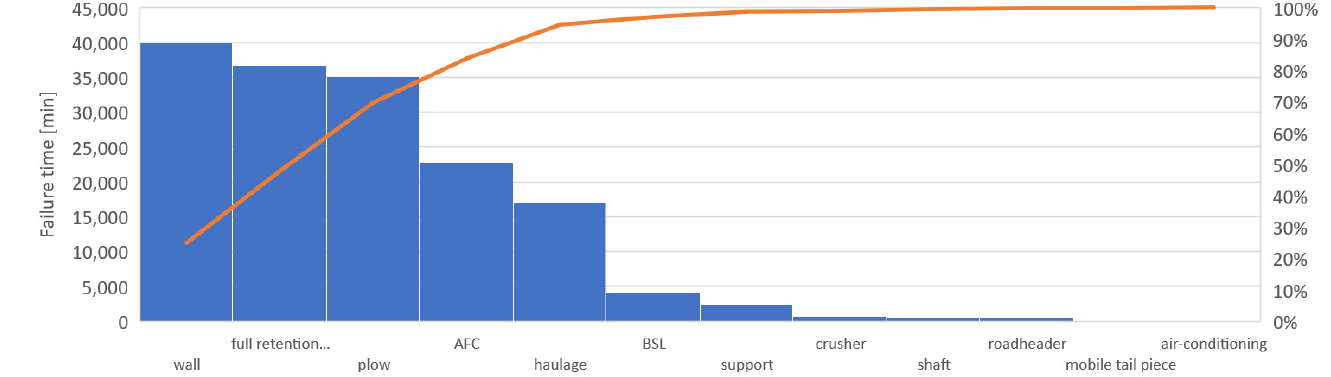
Figure 11. Pareto chart for the total failure time/duration of failures of plow longwalls.